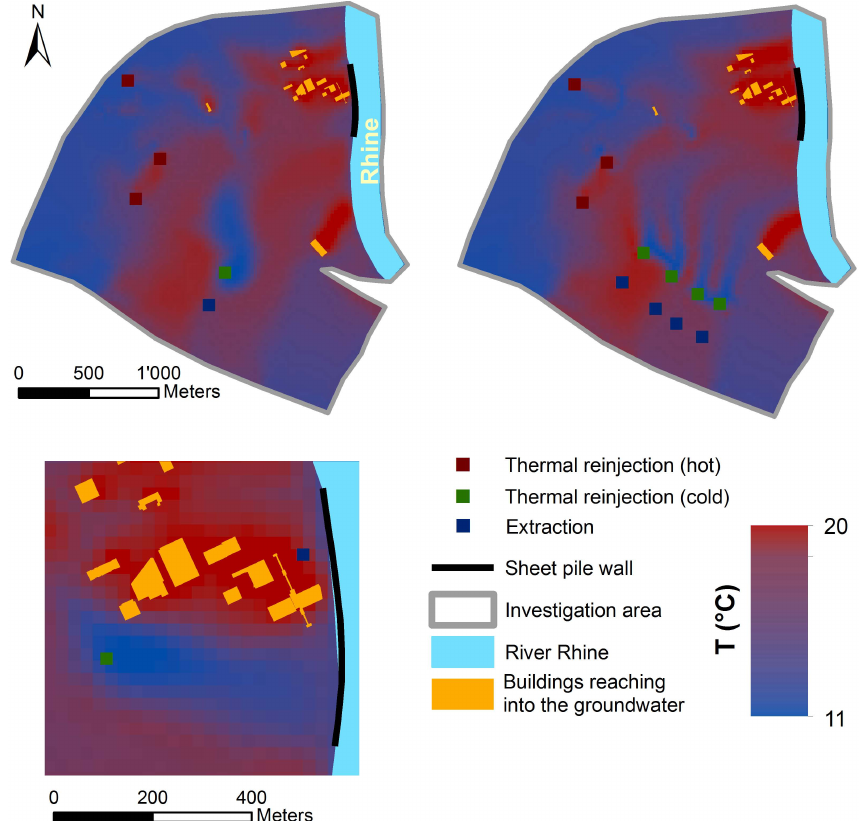
Fig. 11. Calculated temperature distribution after 10yr for scenarios of new groundwater use for heating (for locations see Fig. 1). Upper left panel: new groundwater use within the southern inflow area (zone B); upper right panel: gallery of new groundwater use for heating within the southern inflow area (zone B); and bottom left panel: new groundwater use for heating within the northern industrial area (zone C).